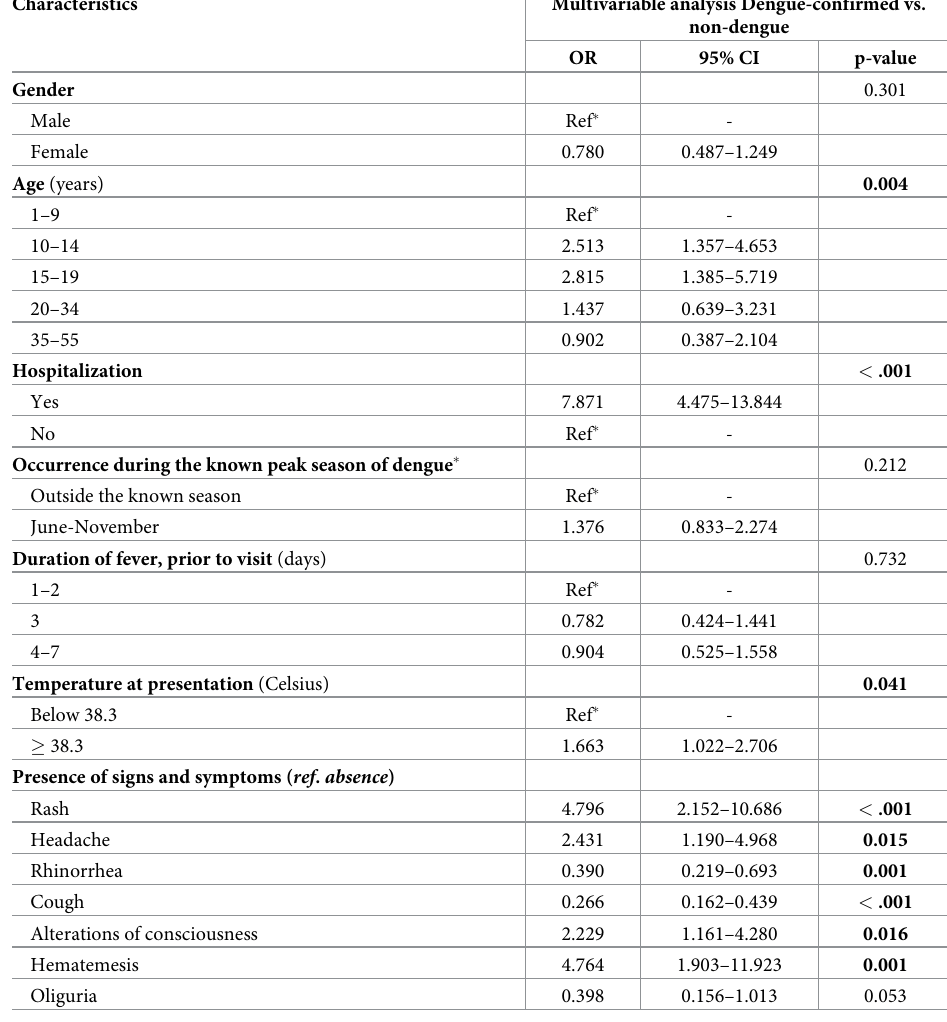
Table 3. Multivariable logistic analysis showing significant indicators and their odds ratios of dengue confirma- tion in the health facility-based fever surveillance.